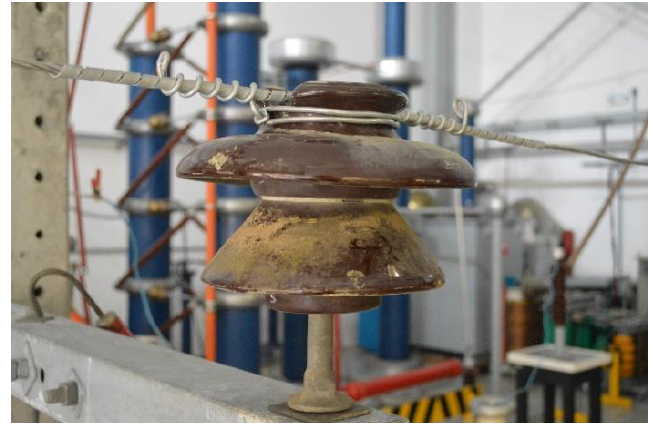
Figure 1. Contaminated insulator removed from a 25 kV rural area distribution system.